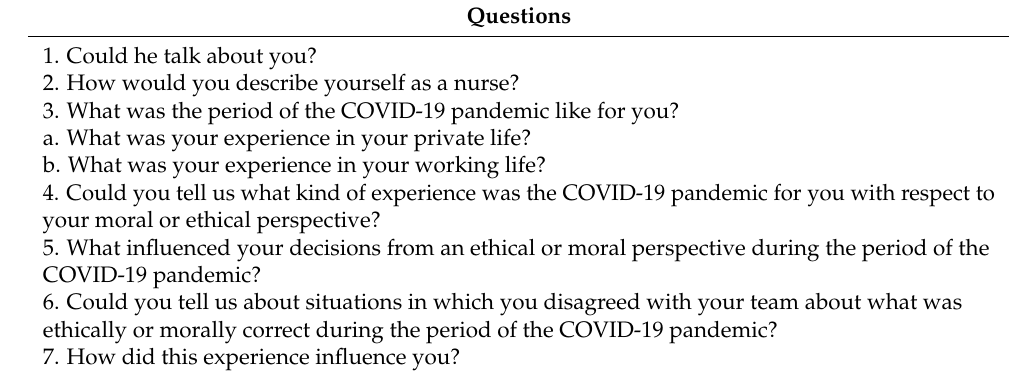
Table 1. Semi-structured interview